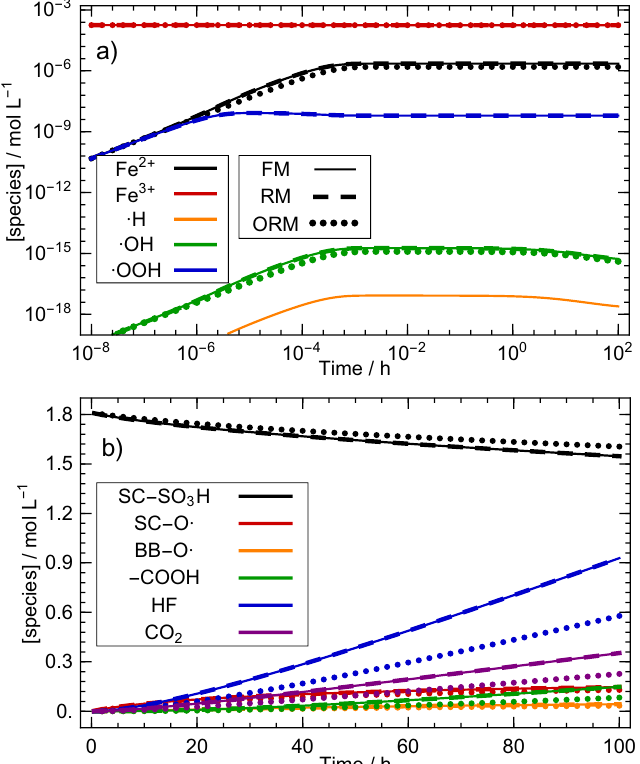
Figure 3. Comparison between species concentrations, calculated with the full model (solid), reduced model (dashed), and over-reduced model (dotted), with initial iron ion concentrations [Fe 2+ ] = 0 ppm, [Fe 3+ ] = 10 ppm and constant hydrogen peroxide concentration [H ( a ) Log-log plot of species concentration involved in the iron redox reactions. ( b ) Concentration of specific groups of the perfluorinated membrane and the products of membrane degradation. The results of the full and the reduced model coincide perfectly, while the results of the over-reduced model are slightly